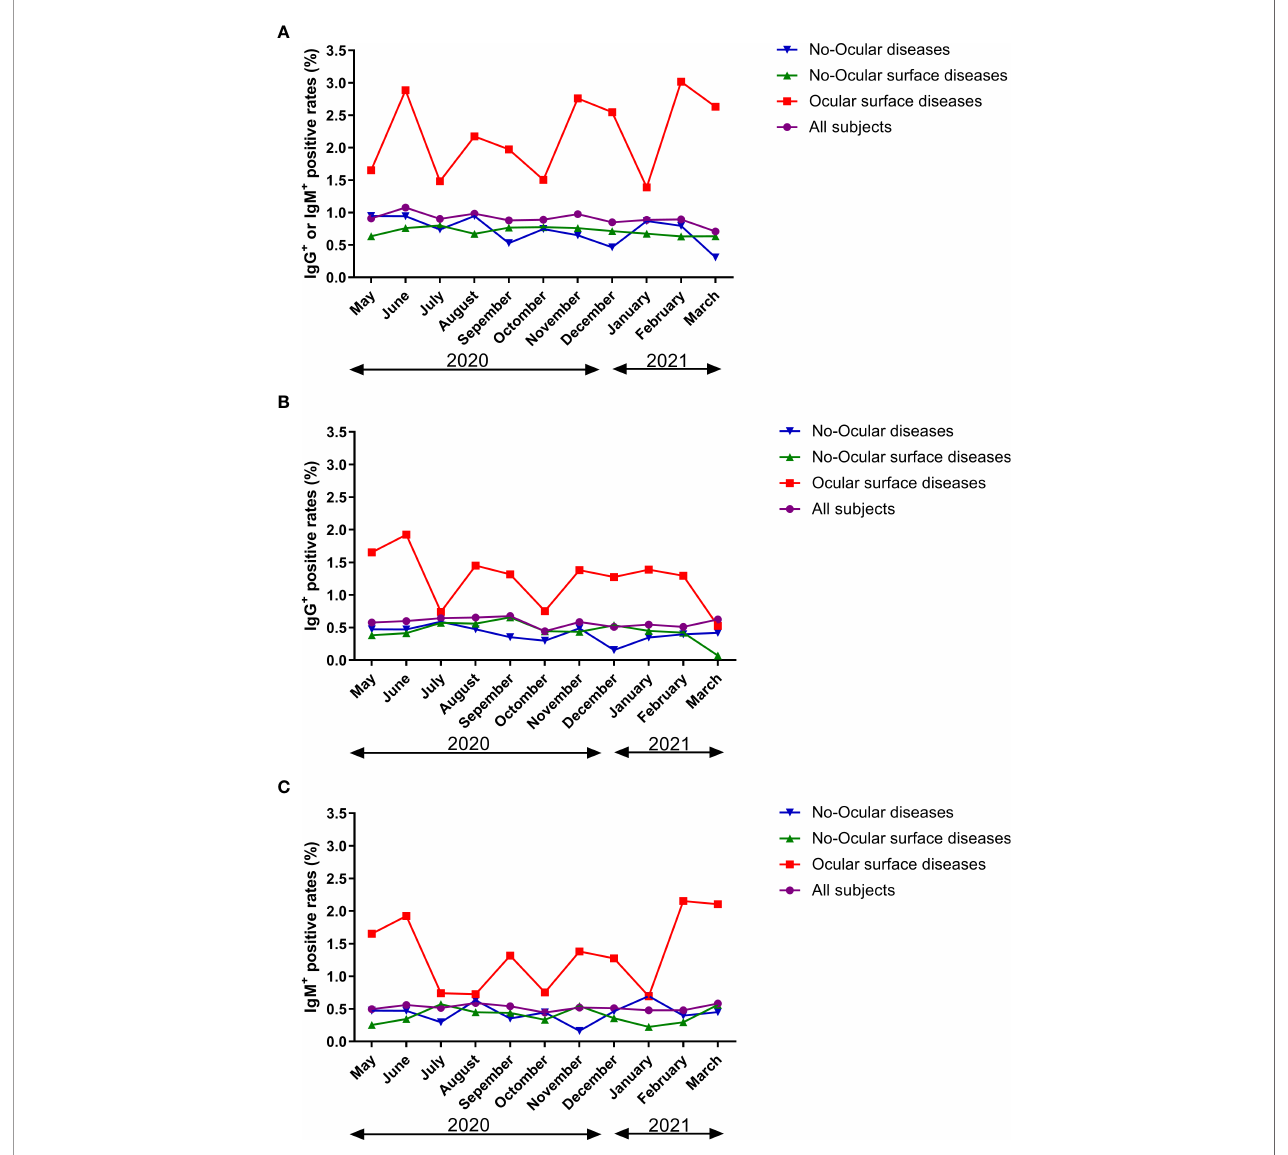
FIGURE 6 | The seroprevalence of antibodies to SARS-CoV-2 in time period subgroup ( A : IgG + or IgM + , B : IgG + , C : IgM + ). Survey seroprevalence was based on the following numbers of positive tests/sample sizes: 11/1211(May 2020), 27/2506 (June 2020), 14/1553 (July 2020), 15/1528 (August 2020), 13/1481 (September 2020),